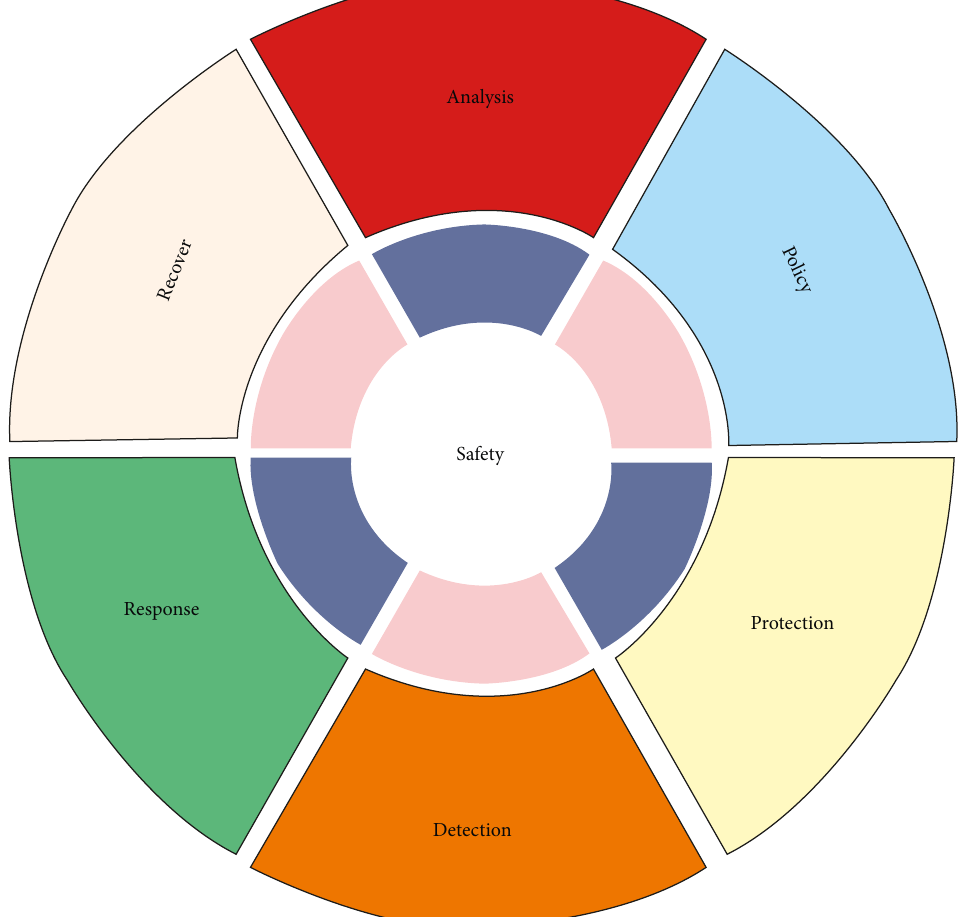
Figure 4: APPDRR